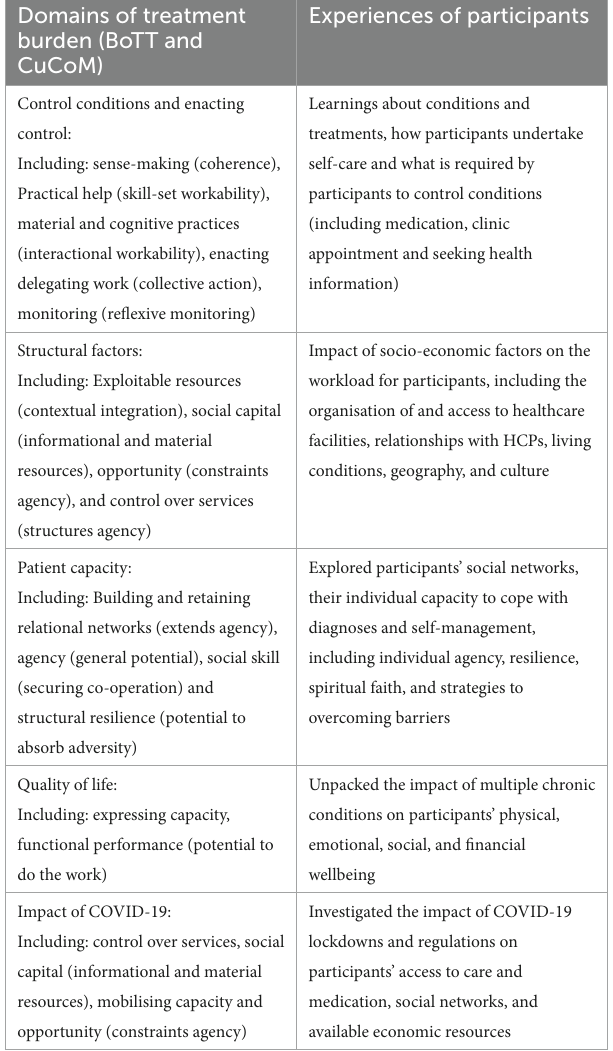
TABLE 1 Domains of treatment burden and the experiences of participants in Gugulethu and Bulungula. Domains of treatment burden (BoTT